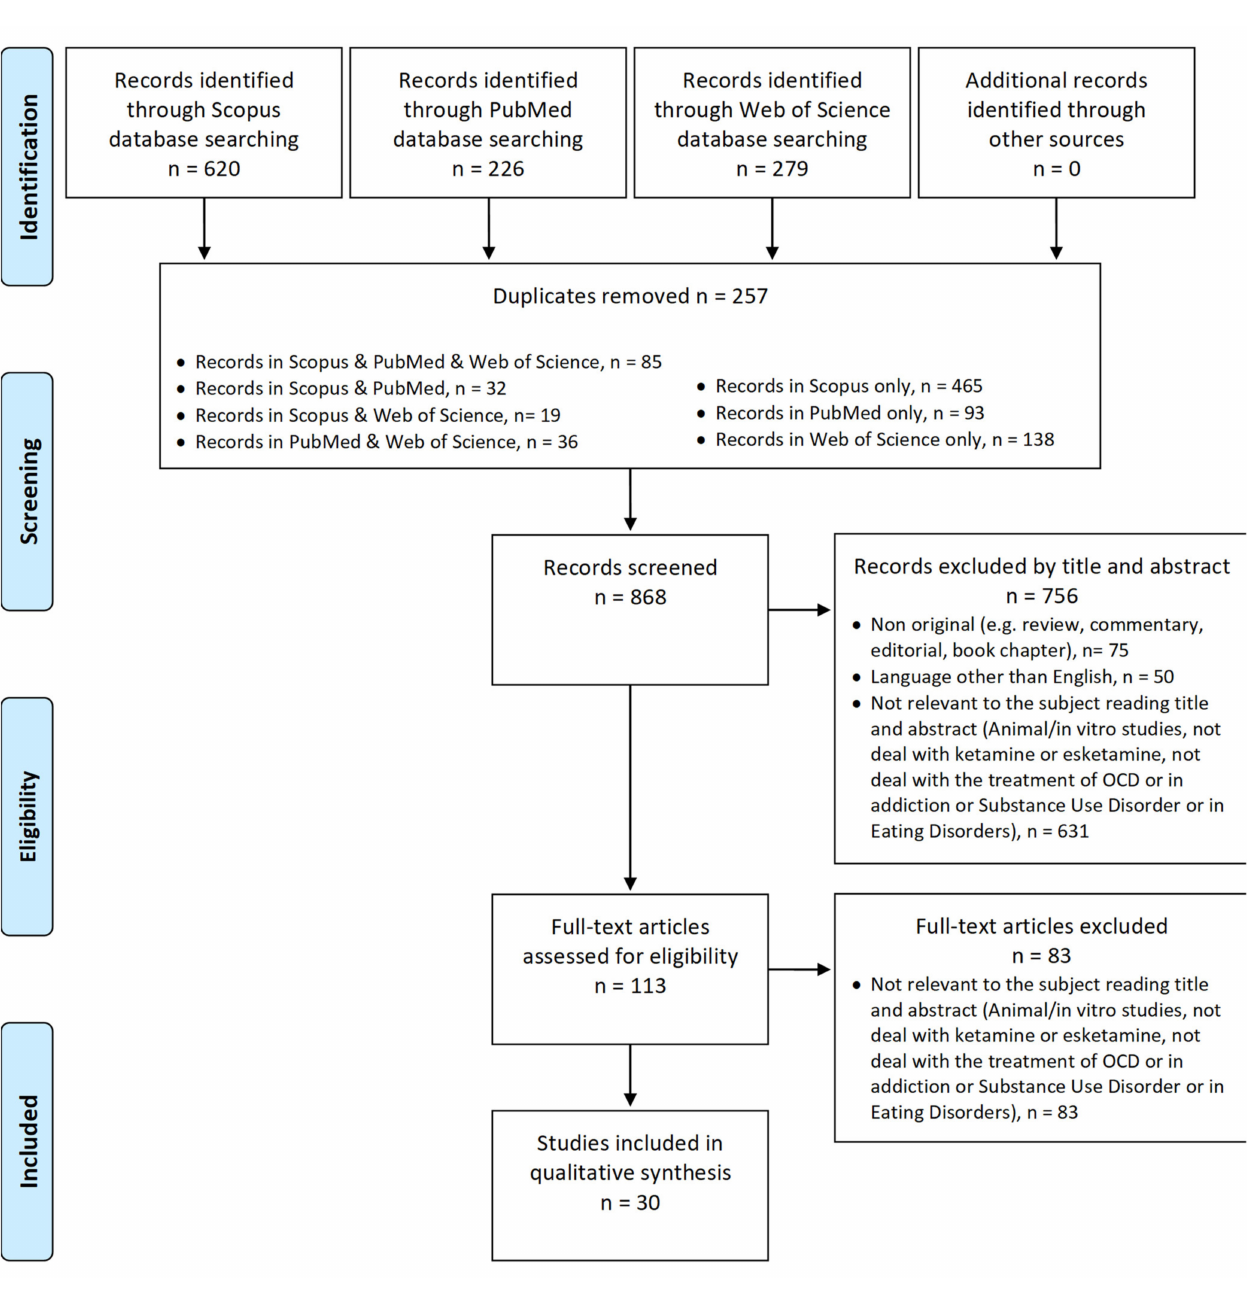
Figure 1. Flow-chart of study search and selection process according to PRISMA